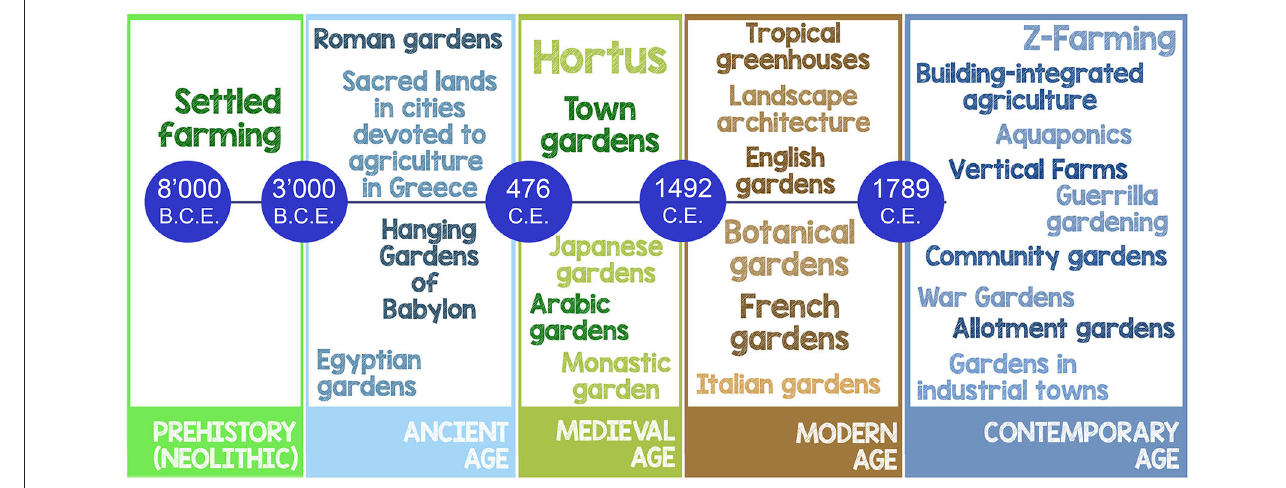
FIGURE 1 | Timeline of relevant keywords along the history of Urban